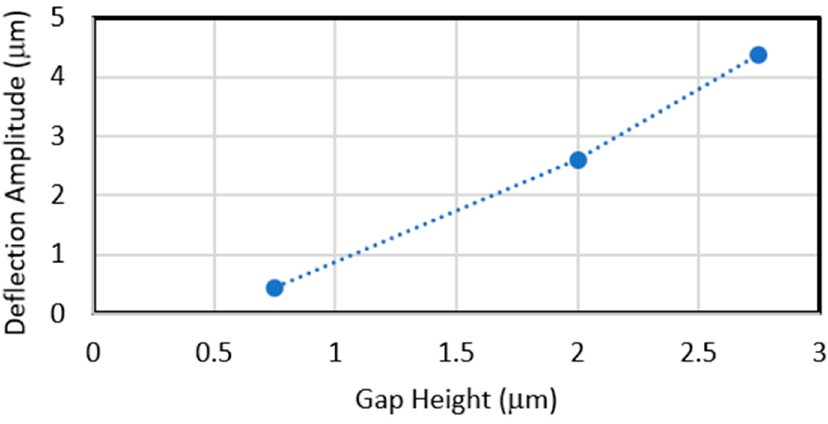
Figure 10. COMSOL simulation results presenting the effect of the gap height on the maximum upward deflections of the designed micromirrors.